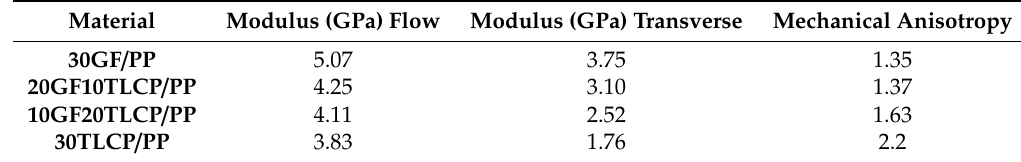
Table 1. Mechanical anisotropy of the hybrid